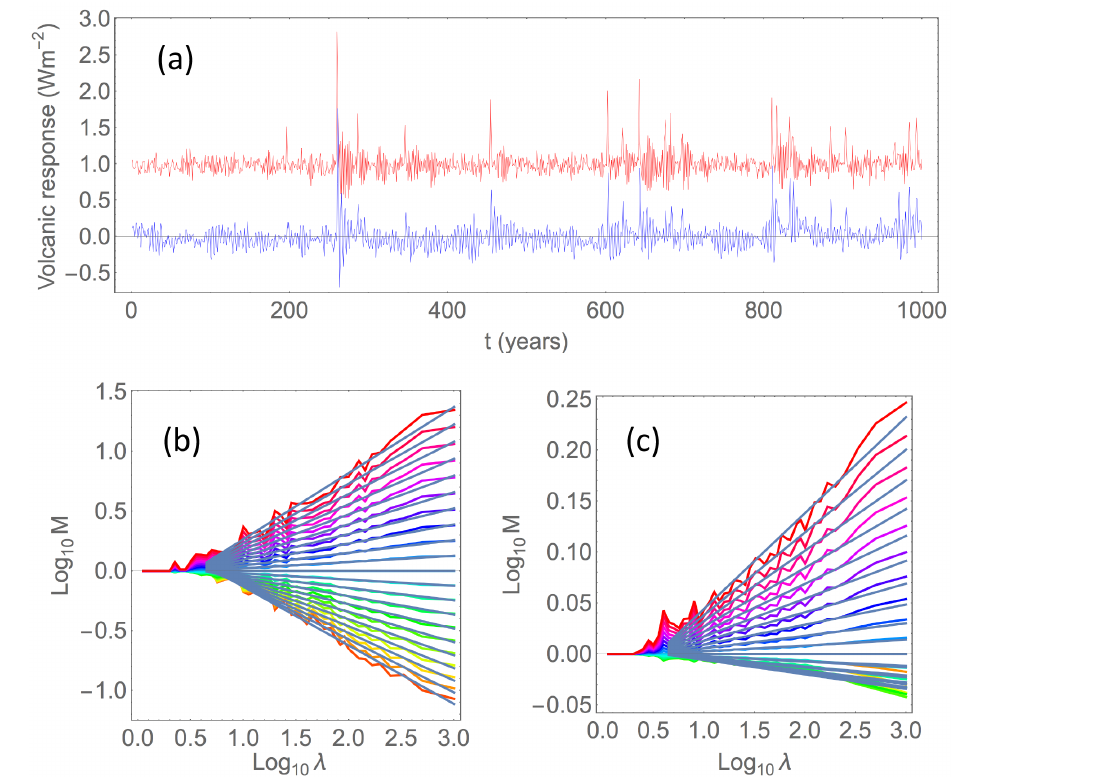
Figure 7. (a) Blue curve is the average over 100 realisations of the response to volcanic forcing in the ZC model, and the red curve is the response to this forcing plus a stochastic Gaussian white-noise forcing in a linear, damped harmonic oscillator model. (b) Result of trace- moment analysis of the volcanic forcing signal. It is very similar to the corresponding panel in Fig. 6 of L&V. (c) Result of trace-moment analysis of the harmonic oscillator response shown by the red curve in panel (a) . It is very similar to the corresponding panel for the ZC response to volcanic forcing in Fig. 6 of